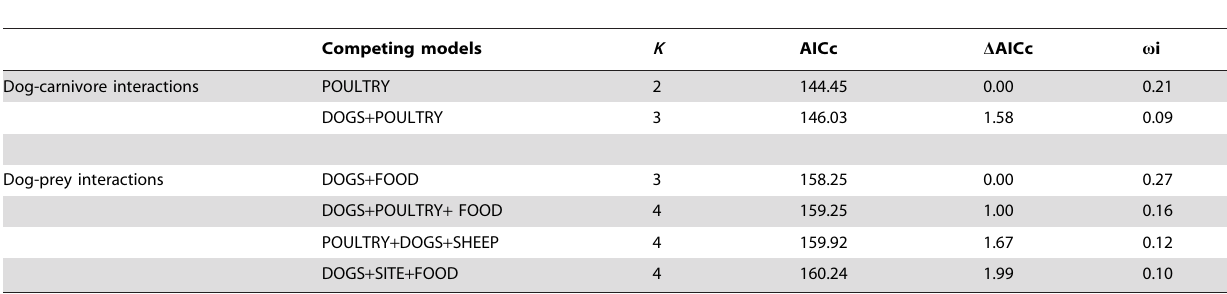
Table 3. Best models to estimate the probability of owned dog interactions with carnivores and prey species.